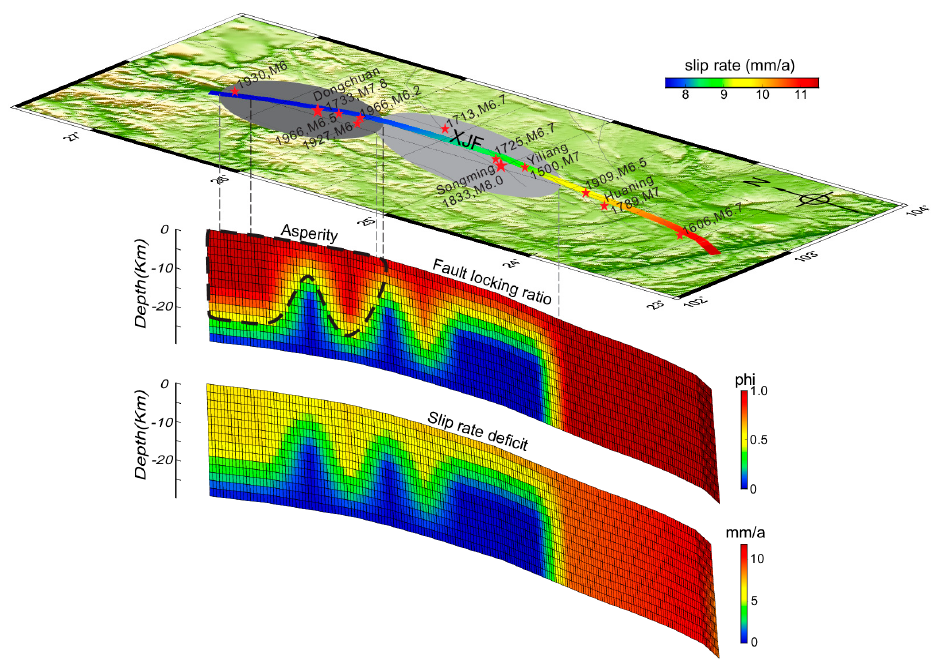
Figure 4. Image of the slip rate ( top ), locking ratio ( middle ), and slip deficit ( bottom ) of the XJF. The red stars are the M > 6.5 earthquakes since 1500 and the M > 6 earthquakes in the past 100 years. The asperity, defined by the fault locking ratio and the slip rate deficit, is emphasized with the black dashed line. The rupture distributions (gray areas) of the 1733 Dongchuan M 7.8 and 1833 Songming M 8.0 earthquakes are from Wen et al. [16] and historical earthquake material.